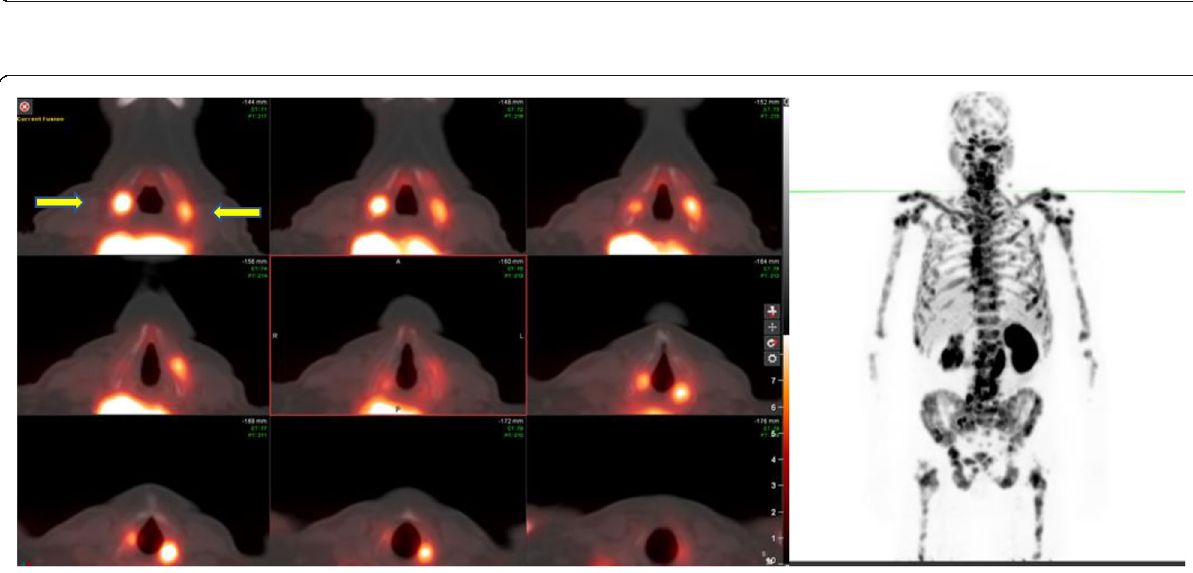
Fig. 3 68 Ga-PSMA-11 PET/CT scan images (fused PET/CT images) of a 66-year-old man with castrate-resistant metastatic prostate cancer. The PSA at the time of the scan was 973 ng/ml. The fused axial images of the neck show very avid lesions at both sides of the thyroid cartilage (yellow arrows) and also on the left side of the cricoid cartilage (white arrow). MIP whole-body image shows multiple osseous metastatic